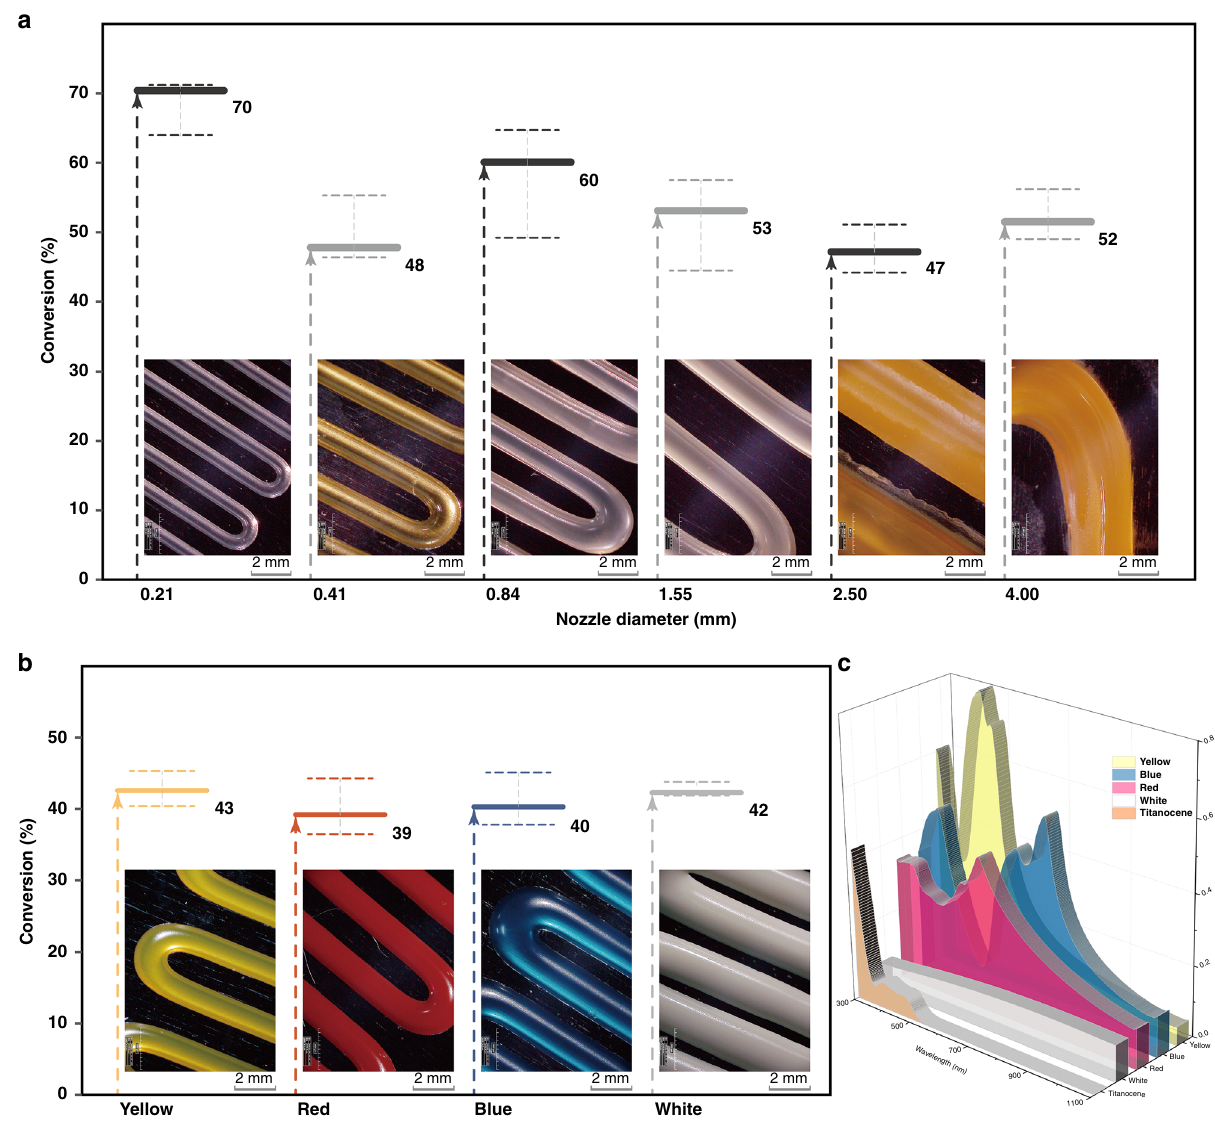
Fig. 3 Patterned fi laments utilizing different nozzles and colored inks. The conversion of vinyl group vs. a nozzle diameter or b colors as monitored by ATR-FTIR, and error bars are reported as standard error of mean, and the scale bar is equivalent to 2 mm; c absorption spectra of titanocene and pigments used in different formula.